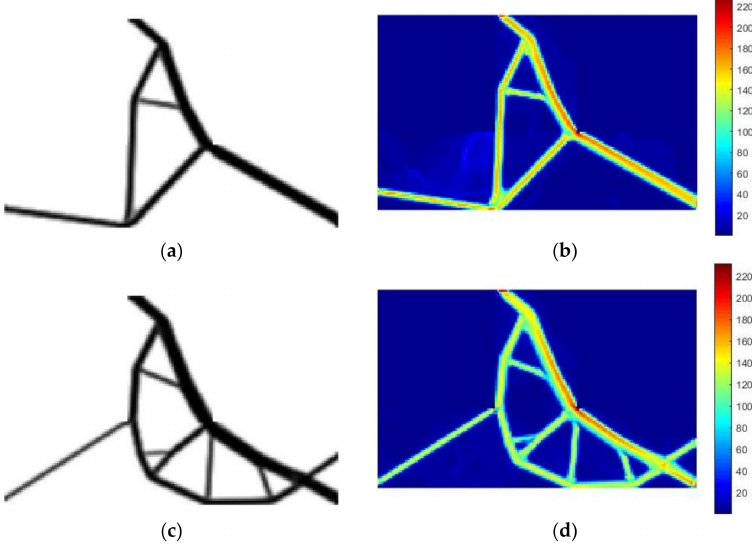
Figure 14. Topology optimization results of T-beam ( ∆ T = 20 ◦ C): ( a ) DTO topological structure ( b ) DTO Von Mises stress distribution; ( c ) RBTO topological structure; ( d ) RBTO Von Mises stress distribution.